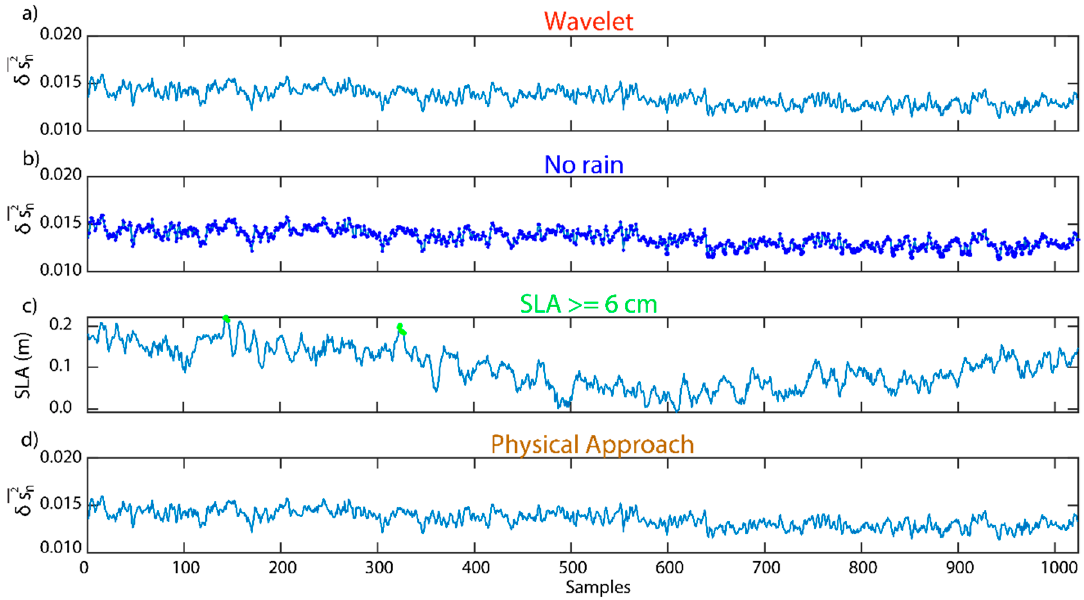
Figure 15. ( a ) Along-track SRAL record of δ s 2 n with wavelet analysis (no detections). ( b ) The same record with all cells passing the “no rain” criterion in this paper (dark blue). ( c ) The few SLA variations exceeding the threshold (6 cm) used in this paper (green dots) do not match any detections in the ( a ) wavelet or ( d ) physical approach criterion.